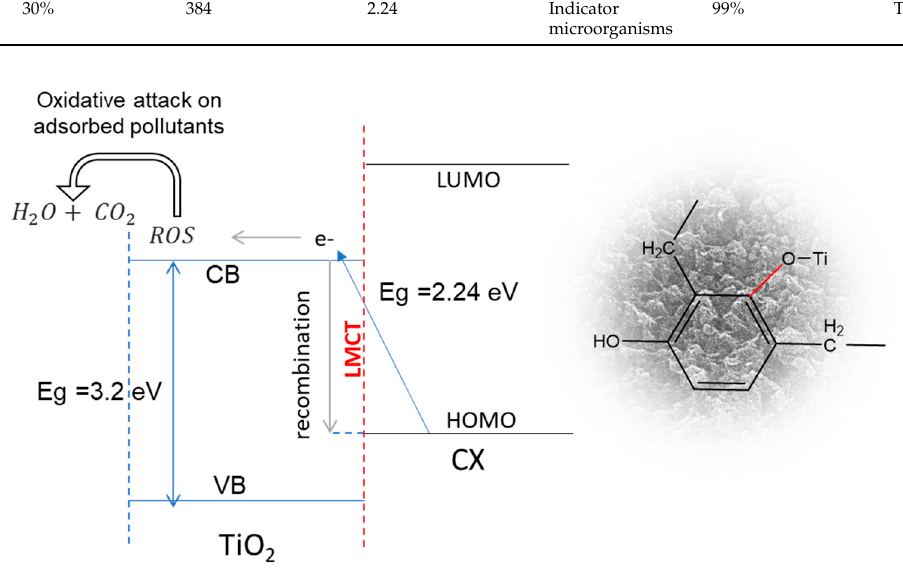
Figure 10. ( a ) UV-Vis absorption spectrum of CXTi synthesised in this study, ( b ) Tauc plot of CXTi, ( c ) post adsorption photocatalytic performance of CXTi under visible light irradiation and ( d ) kinet- ics of combined adsorption and photodegradation of MB on